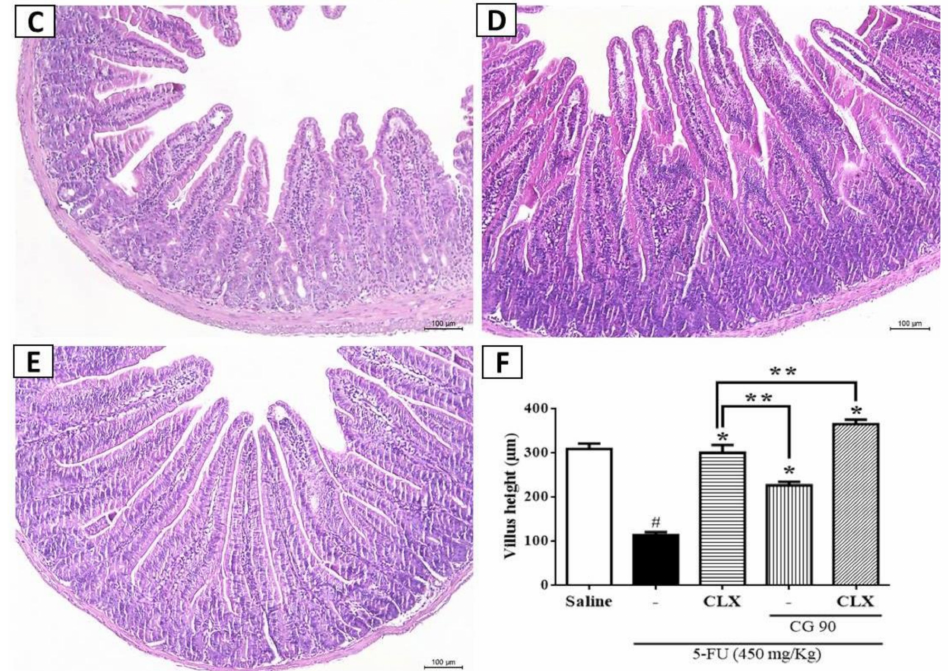
Figure 5. E ff ect of GC on the cyclooxygenase-2 pathway (COX-2) in histopathological and morphometric. The histopathological analysis represented by the groups ( A ) Saline; ( B ) 5-FU; ( C ) CG 90; ( D ) Celecoxib (CLX); ( E ) CLX and CG 90, as well as morphometric analysis of villus height ( F ) showed that 5-FU caused a decrease in villi and loss of cellular architecture when compared to the saline group. C, D, and E reversed the e ff ect of 5-FU. All panels were obtained at × 200 magnification. Values were expressed as mean ± SEM for villi height in µ m. For statistical analysis, one-way ANOVA followed by Tukey’s test was used, where # p < 0.05 vs. saline group, * p < 0.05 vs. group 5-FU, ** p < 0.05 vs. group